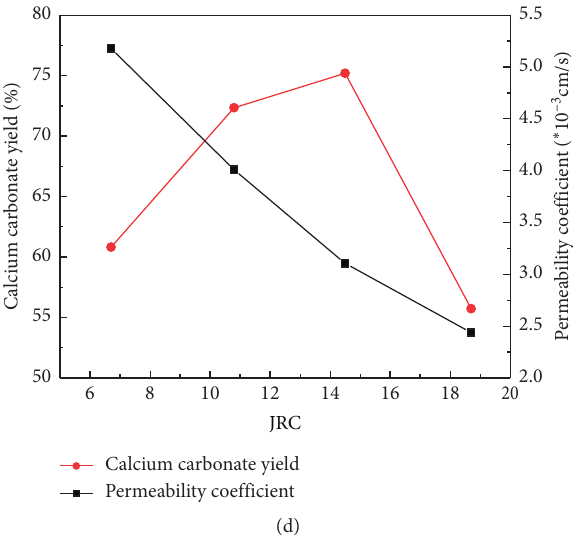
Figure 8: Filling effect of calcium carbonate with different fracture roughness. (a) Calcium carbonate filling process. (b) Specimen after first filling process (JRC � 18.7). (c) Change of calcium carbonate content. (d) Change of fracture